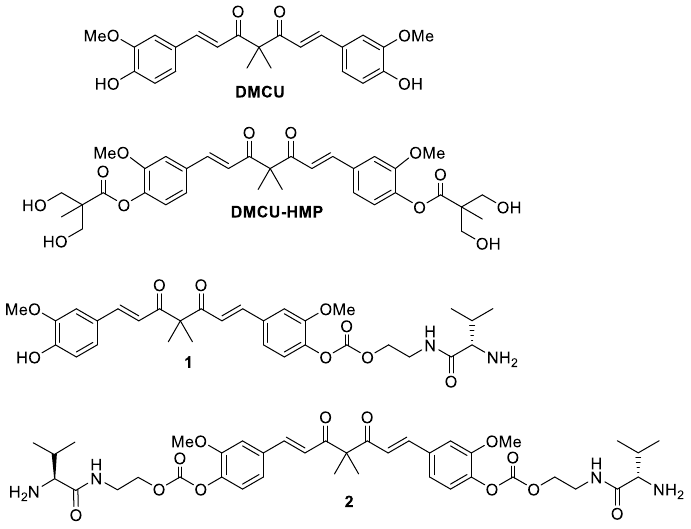
Figure 1. Structure of DMCU, DMCU-HMP, 1 and 2.